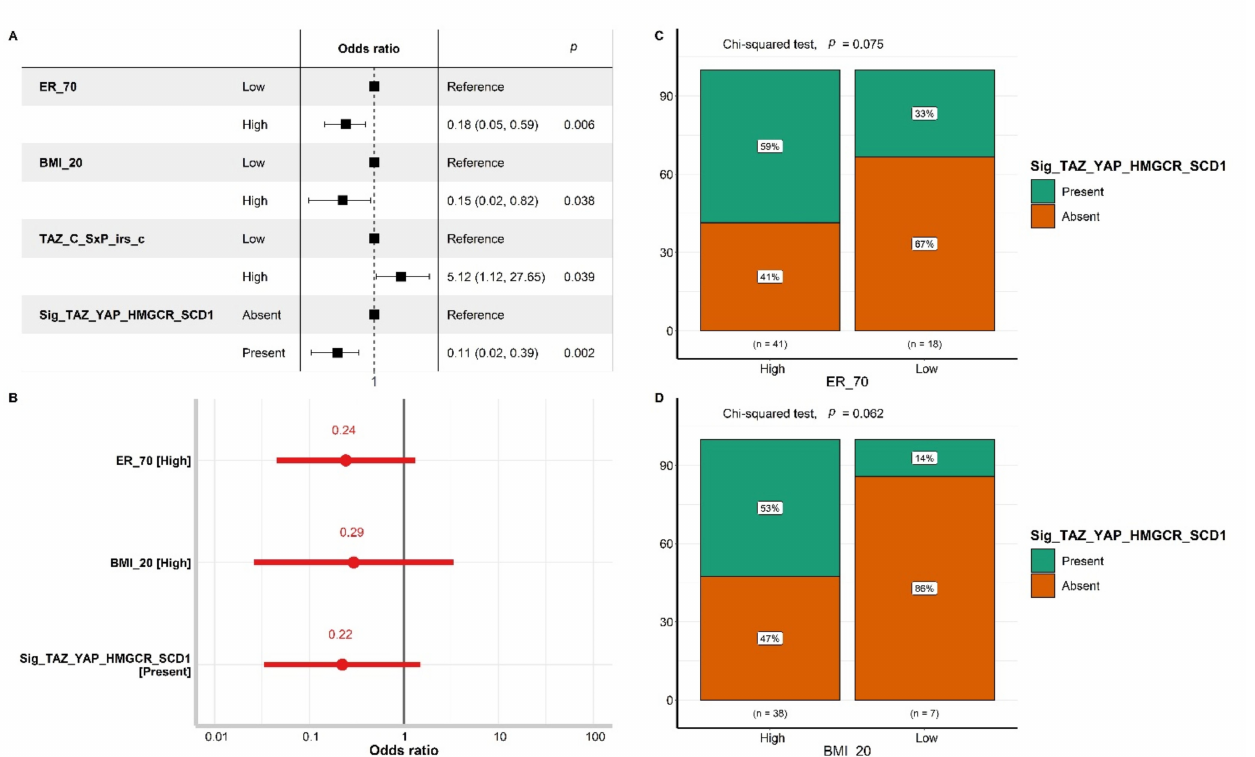
Figure 7. ( A ) The univariate logistic model for the variables that showed a statistically significant ef- fect on pCR. ( B ) The multivariate logistic model which includes all the variables showing a significant impact on pCR in the univariate model. ( C , D ) The distribution of Sig_TAZ_YAP_HMGCR_SCD1 in the two categories of ER (ER > 70% vs. Others) and BMI (BMI > 20 vs. Others), respectively. Statistical comparison was performed using the Chi-squared test. Abbreviations: ER_70 = estro- gen receptor with cut-off at 70% (ER > 70% vs. Others); BMI_20 = body mass index with cut- off of 20 (BMI > 20 vs. Others); Sig_TAZ_YAP_HMGCR_SCD1 = signature of cytoplasmic TAZ score 0–1, nuclear YAP score 0–1, nuclear HMGCR score 0, and cytoplasmic SCD1 score 1–3. Suffixes: _C = cytoplasmic; SxP_irs_c = categorized international immunoreactive